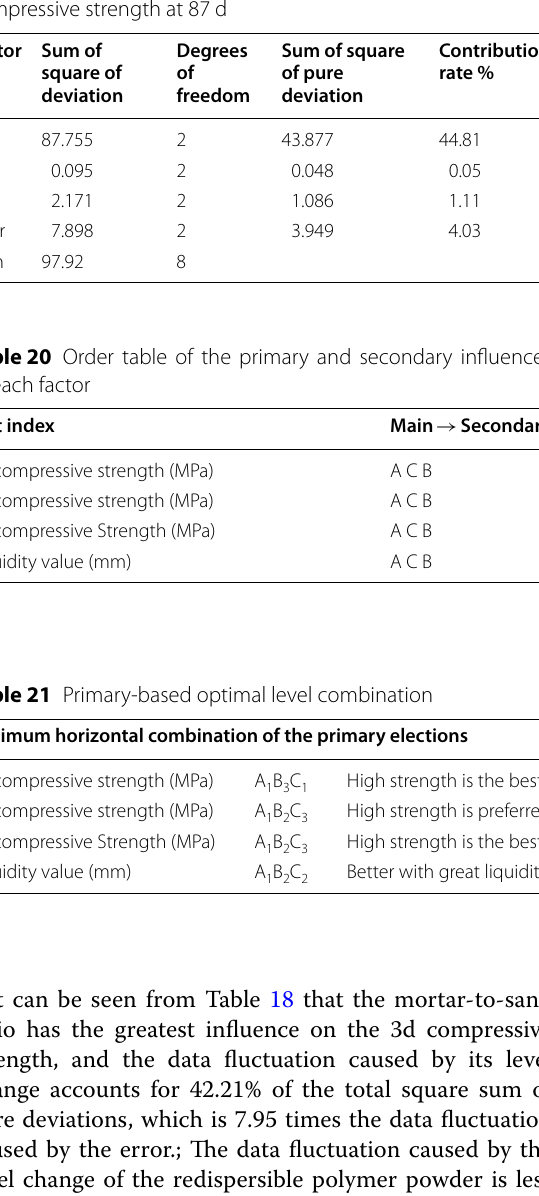
Table 19 Contribution results of factors and error under